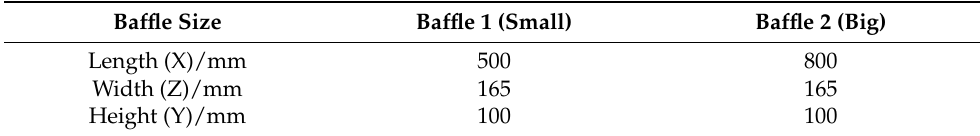
X (5635 mm from the taphole), Y (the midpoint of the main trough wall), Z (the wall).